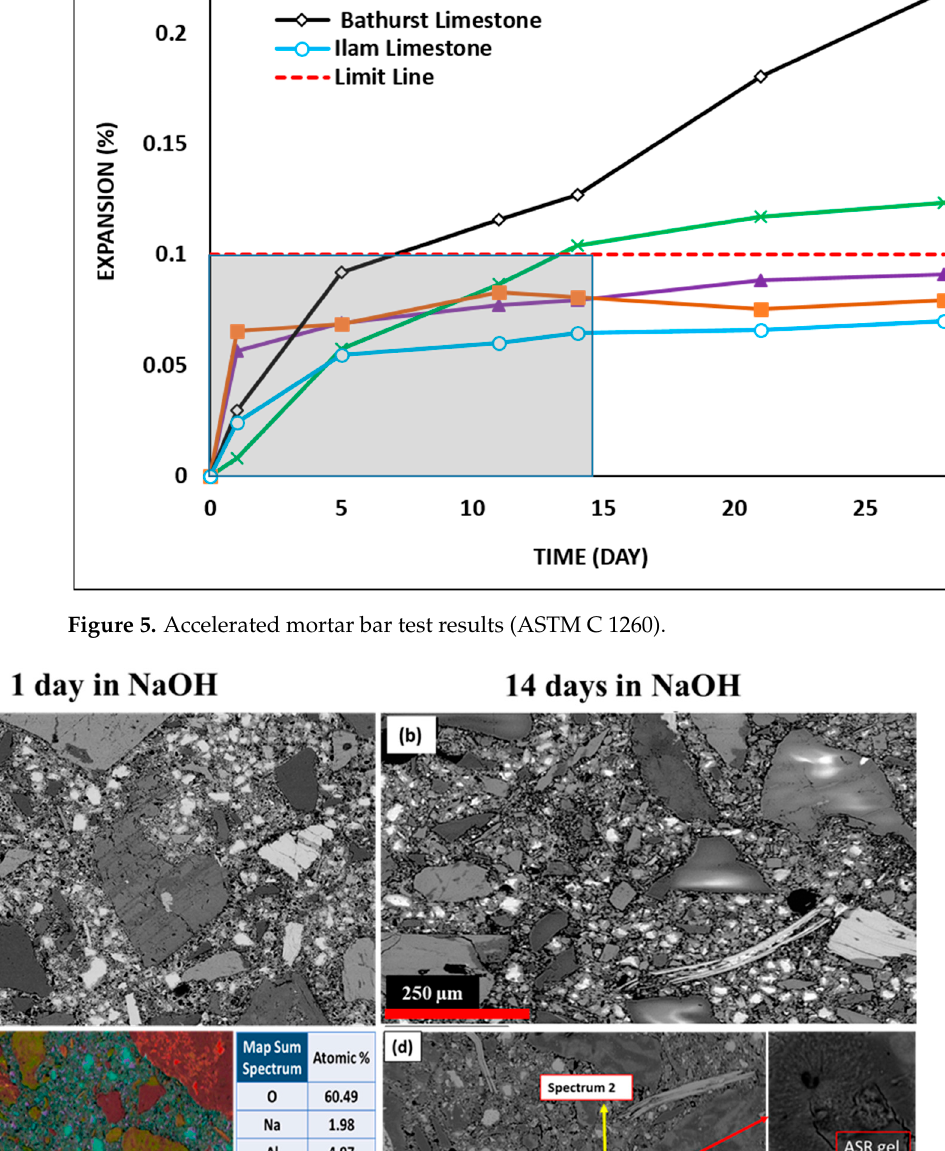
Figure 6. Comparison of SEM micrographs of ( a ) granite (1 day), ( b ) granite (14 days), ( c ) rhyodacite (1 days) and ( d ) rhyodacite (14 days) immersed in NaOH solution.